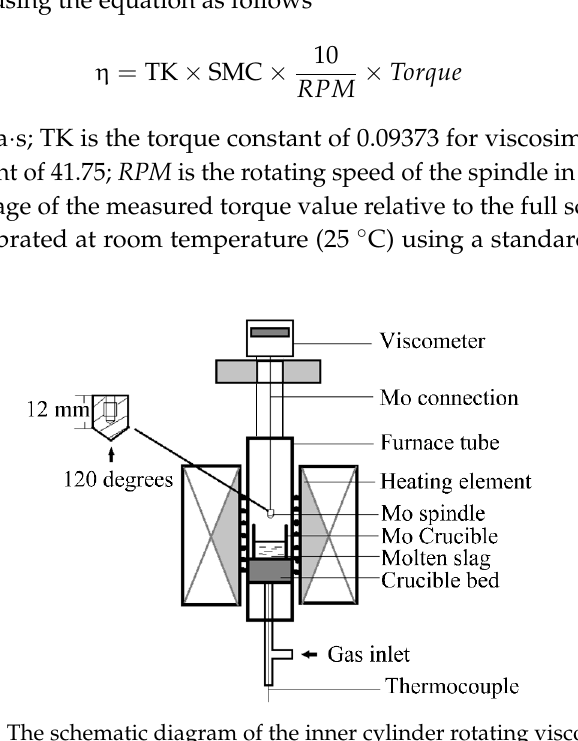
Figure 2. The schematic diagram of the inner cylinder rotating viscometer.